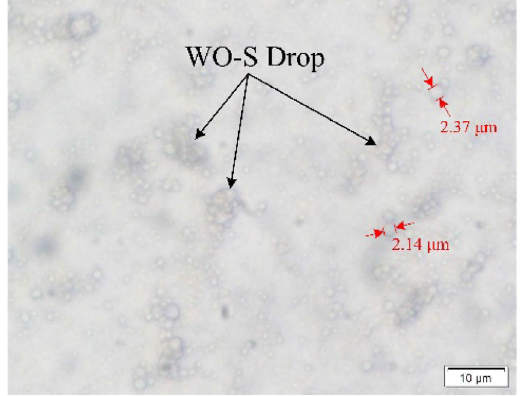
Fig. 13 Micrograph of droplet size distribution in WO-S (1.5 wt.%) cutting fluids.